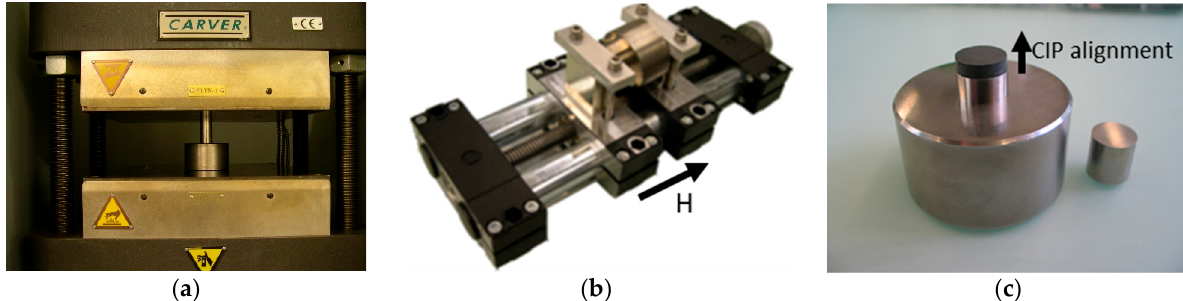
Figure 1. ( a ) Warm-pressing of the MRE samples, ( b ) pre-structuring the MRE sample under magnetic field H, and ( c ) CPI alignment in the TPE-based MR elastomer.